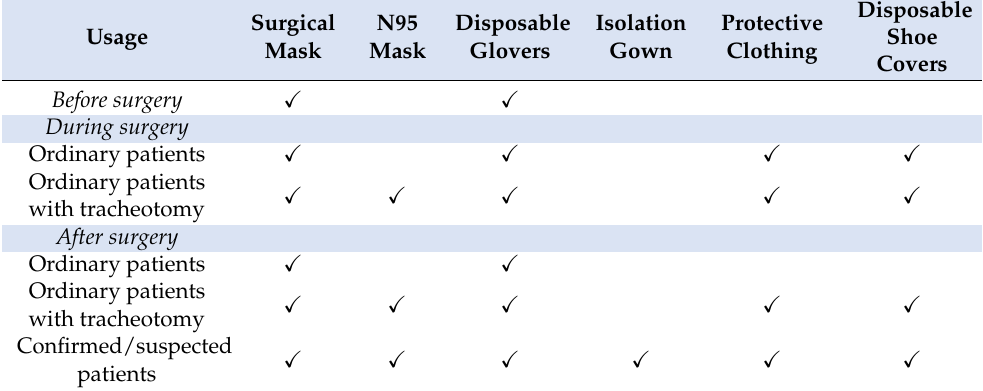
Table 1. Personal protective equipment (PPE) requirements for medical